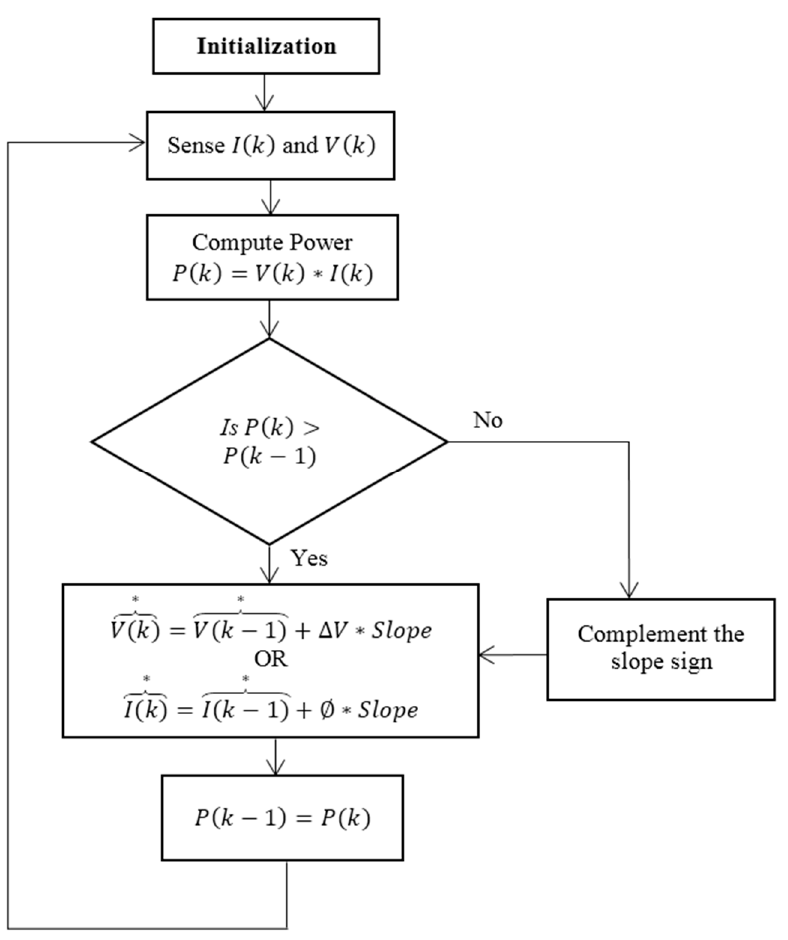
Figure 6. Flow chart of the conventional Perturb and Observe (P&O) method [37].